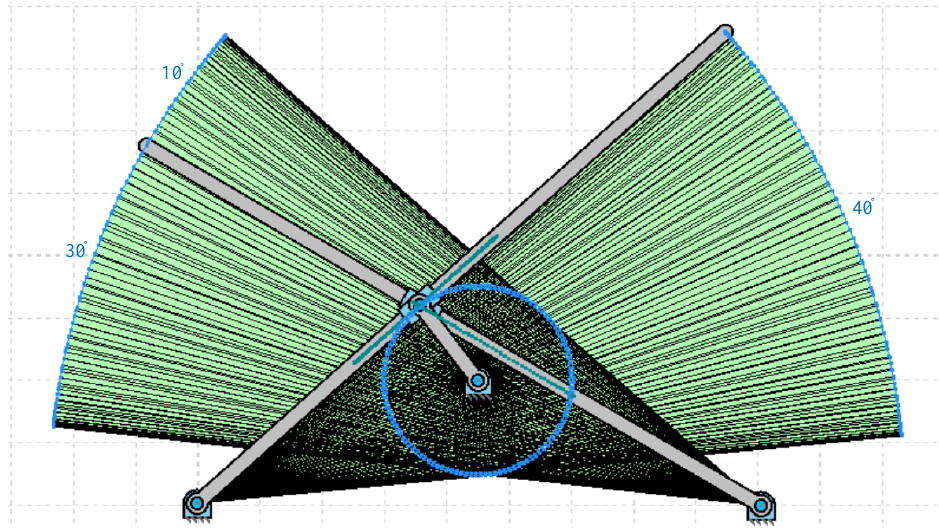
Figure 3. Workspace of the modeled SC-SDL design mechanism-I.